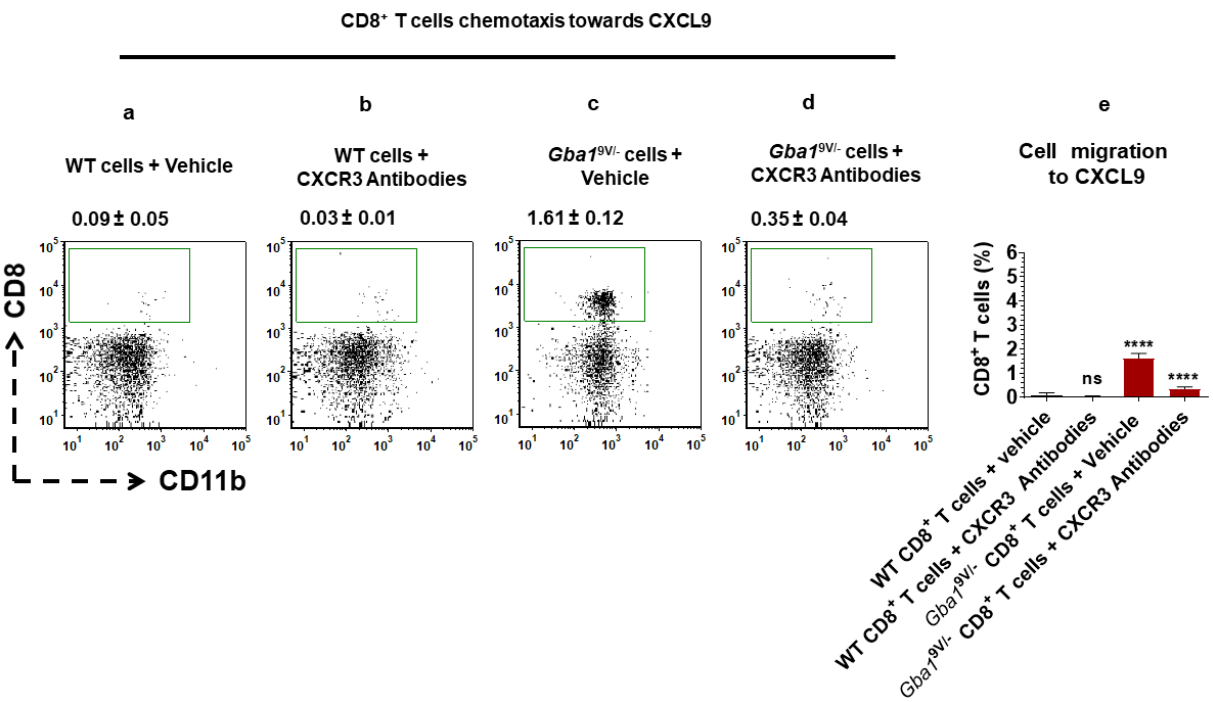
Figure 5. CXCR3 targeting alters CXCL9-mediated CD8 + T cells chemotaxis in Gba1 9V/ − mice. CD8 + T cells purified from spleens of WT and Gba1 9V/ − mice ( n = 5/group) were allowed to migrate towards CXCL9 (16 nM) in the presence and absence of mouse anti-CXCR3 antibodies (10 µ g/mL) at 37 ◦ C and 5% CO 2 for 45 min. Cells that had migrated through the filter and had attached to the lower side of the filter were collected and analyzed by FACS. Percentage of CD8 + CD11b − T cells are shown from the ( a ) vehicle (PBS) treated WT cells and their migration to CXCL9, ( b ) mouse anti-CXCR3 antibodies treated WT cells and their migration to CXCL9, ( c ) PBS treated Gba1 9V/ − cells and their migration to CXCL9, and ( d ) mouse anti-CXCR3 antibodies treated Gba1 9V/ − cells and their migration to CXCL9. ( e ) WT (black columns), Gba1 9V/ − (maroon columns) and the values shown in the bar diagram are the mean ± SD. and group comparison was performed with ANOVA. Three independent experiments were conducted (**** p < 0.0001).